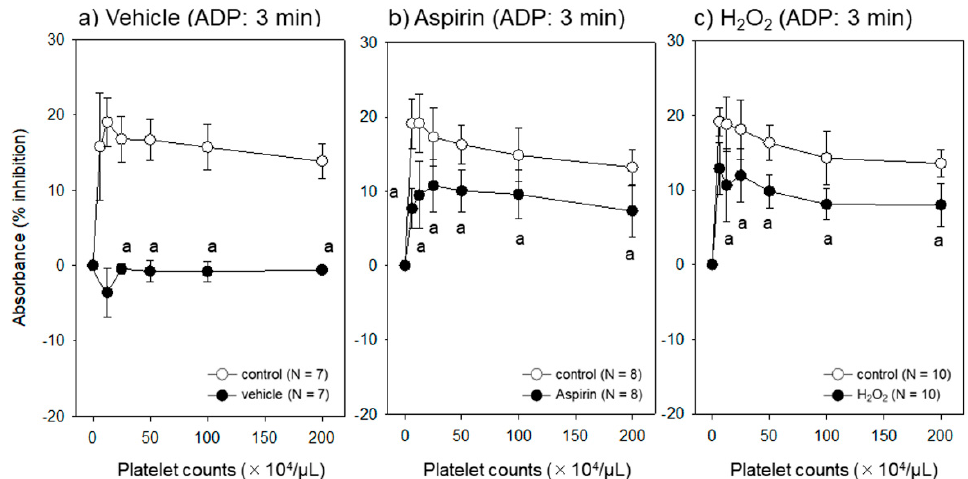
Figure 3. Effect of different platelet conditions on the ADP-induced platelet aggregations. Platelets suspended in acellular plasma were treated with ( a ) a vehicle of aspirin (0.1% dimethyl sulfoxide), ( b ) aspirin or ( c ) H 2 O 2 for 30 min prior to resuspension in PBS and were stimulated with 5 µ M ADP for 3 min. ( a ) The base line was monitored with no addition. a p < 0.05 compared with the control at the same platelet